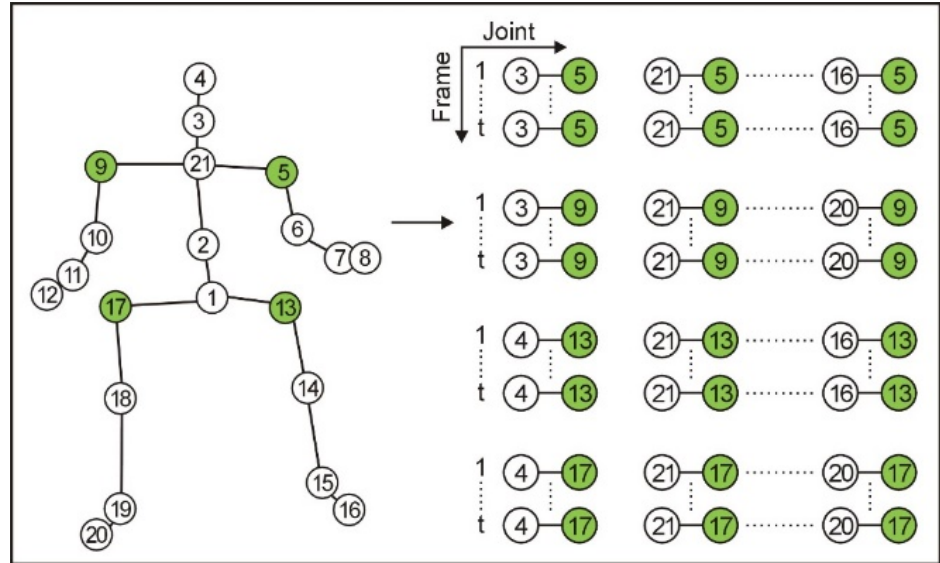
Figure 1. The skeletal sequence created in frames. To begin, the joints of each body part are linked to form a chain of skeleton joints for each frame. (i.e., 1–2–3–…–21) Green points represent the four reference points (i.e., right shoulder 5, left shoulder 9, right hip 13, and left hip 17), which are used to calculate the relative positions of other joints to combine the dissimilar spatial relations between joints. Therefore, all frames of the skeleton are joined at common positions to construct the four 2D arrays according to a cylindrical vertex. The points on the 2D array are transformed into parallel gray